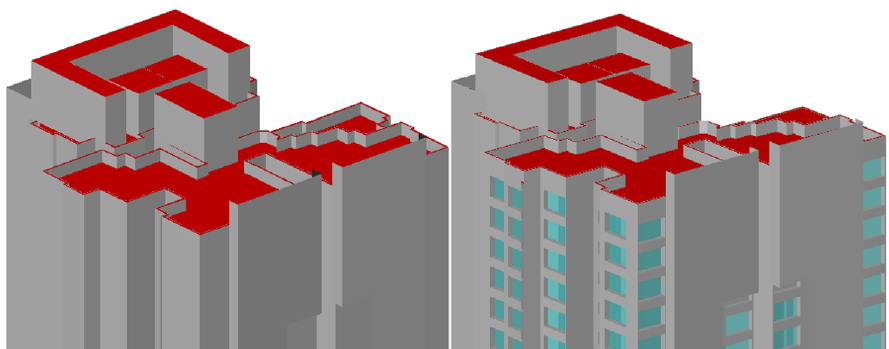
Figure 23. FZKViewer: Data model update for template application. Roofs surfaces in red, wall surfaces in grey, windows in turquoise. Table 1. Test cases for verifying our model synchronization